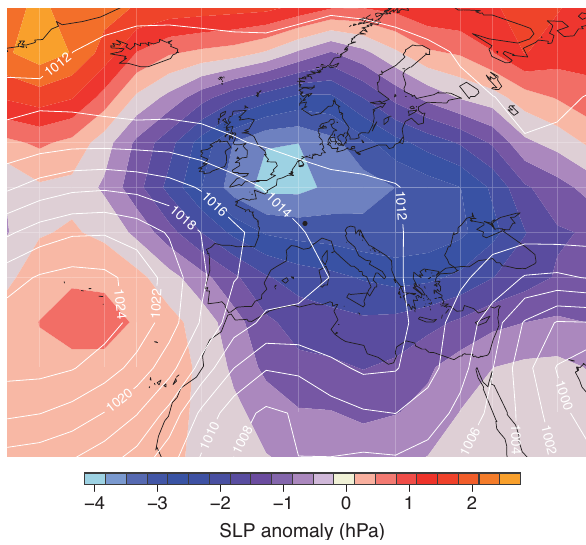
Fig. 7. SLP anomaly for summer (June to August) 1816 with re- spect to the reference period and absolute SLP values (white con- tours). The dot marks the location of